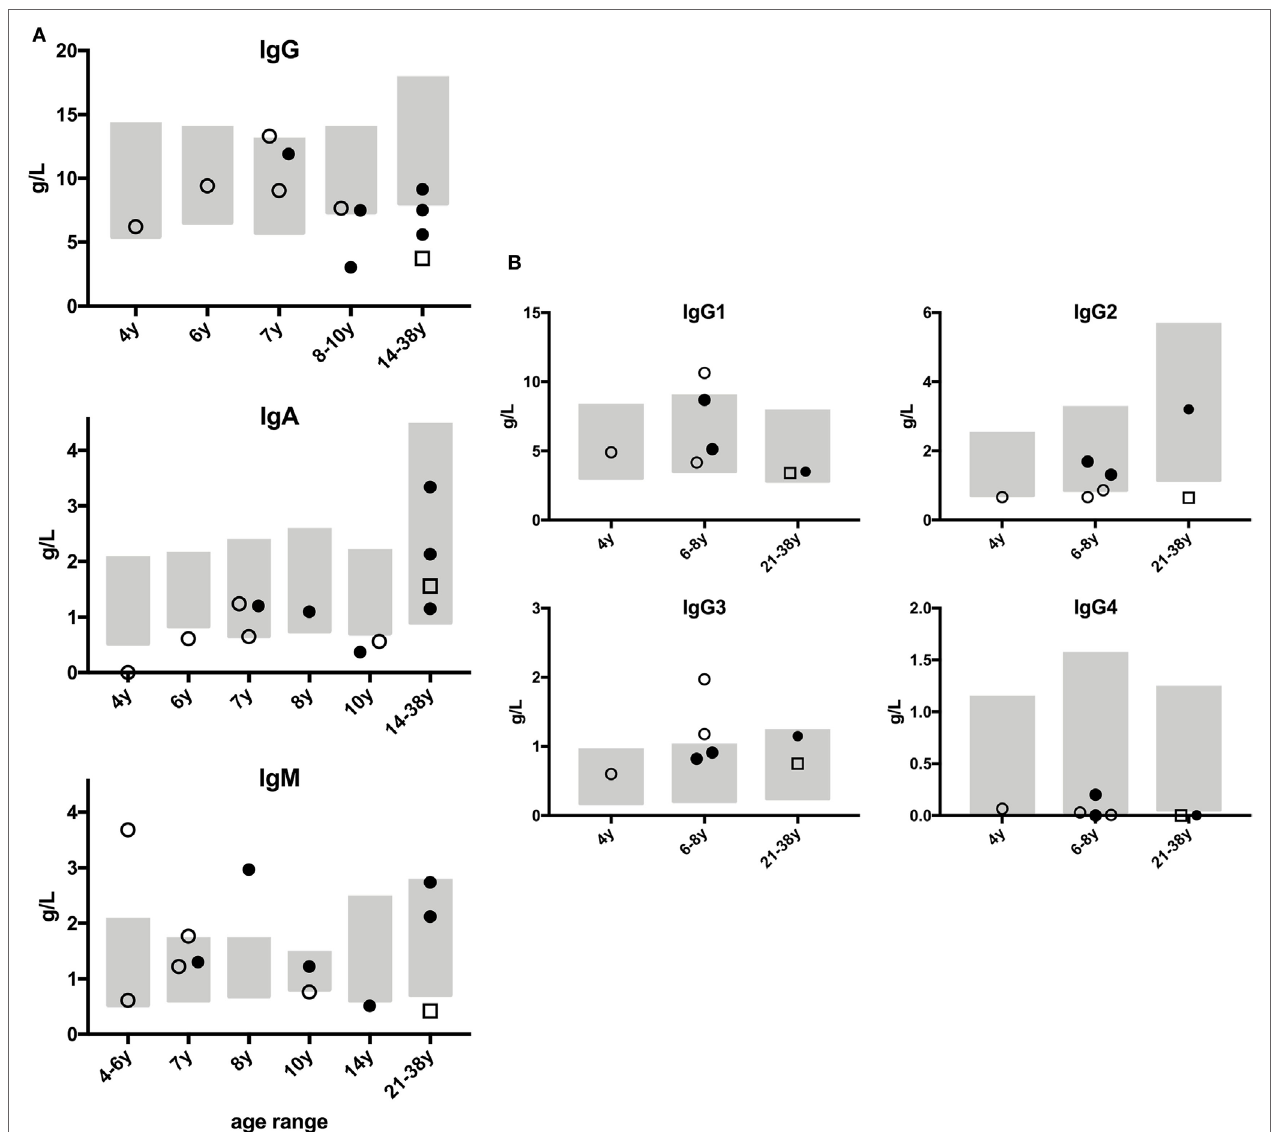
FigUre 1 | Immunoglobulin concentrations of patients with constitutional mismatch repair deficiency. Humoral immunologic analyses were performed locally at the patients’ hospitals, and the results were sent to the study center. None of the patients had received therapeutic (i.v. or s.c.) immunoglobulins within the last 6 months prior to analysis. Results from PMS2-deficient patients are shown as full dots, from MSH6-deficient patients as open dots, and from MLH1-deficient patient as open square. Age-specific normal ranges are shown as gray boxes. (a) Panels show serum concentrations of IgG, IgA, and IgM in g/dl, with age-specific, normal ranges. (B) Graphs show IgG subclass analyses, available from seven patients, related to age-specific, normal ranges to facilitate interpretation. Out of 15 patients, no serological data were available for P12, and those for P8 and P9 were excluded due to their having received prior chemo- or rituximab